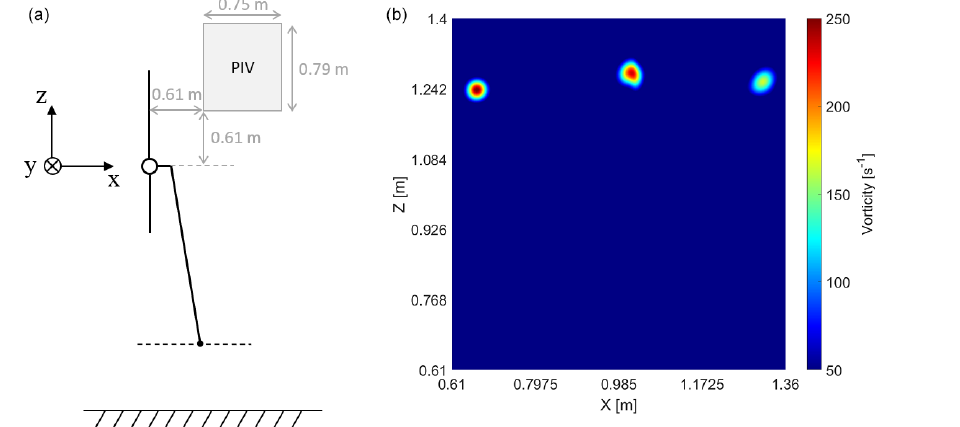
Figure 9. (a) Schematic representation of the wind turbine system and the PIV plane location. (b) Vorticity magnitude in the PIV plane during steady wind when the blade azimuth location is 30 ◦ .